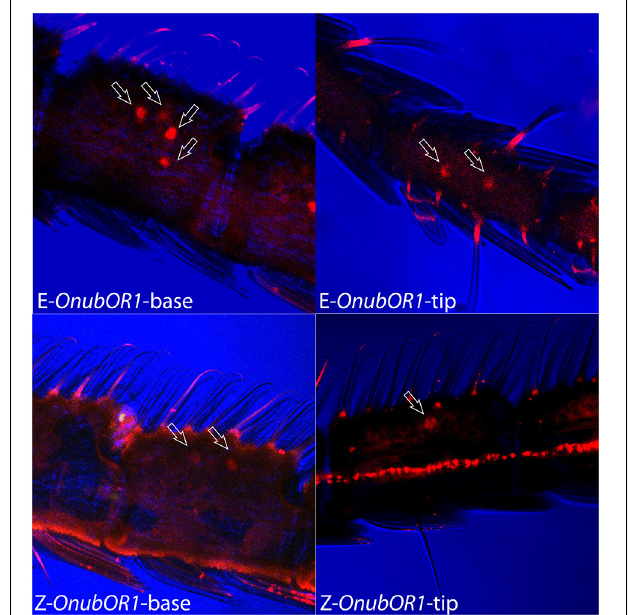
FIGURE 3 | Z and E strain comparison of OnubOR1 transcripts’ expression patterns at the tip and base of the antenna. Arrows indicate cells’